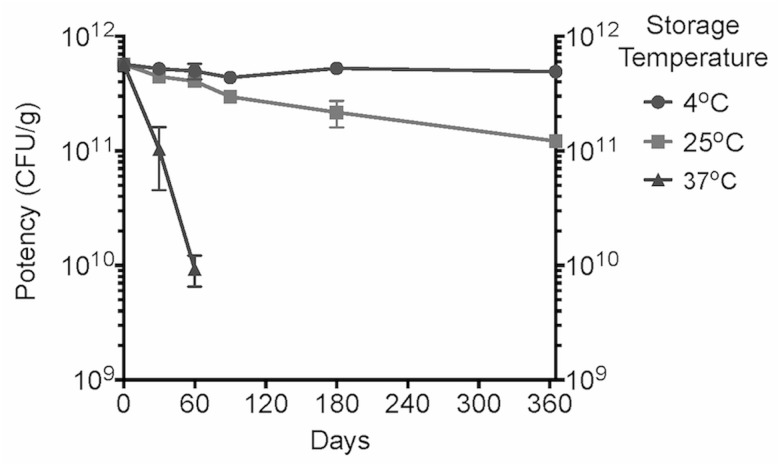
Stability of MucoCept VDTs.Two batches of tablets were prepared and placed in storage at 4°C, 25°C, or 37°C. Potency was measured as CFU/g at time zero, one, two, three, six, and 12 months to assess stability. The mean initial potency of the tablets was 5.7x1011 CFU/g. Error bars represent the standard error of the mean (SEM). The potency of tablets stored at 4°C and 25°C for one year was 4.9x1011 CFU/g and 1.2x1011 CFU/g, respectively. Tablets stored at 37°C lost 1.8 log10 CFU/g of their initial potency after two months (to 9.4x109 CFU/g). Stability at 37°C was discontinued after two months.